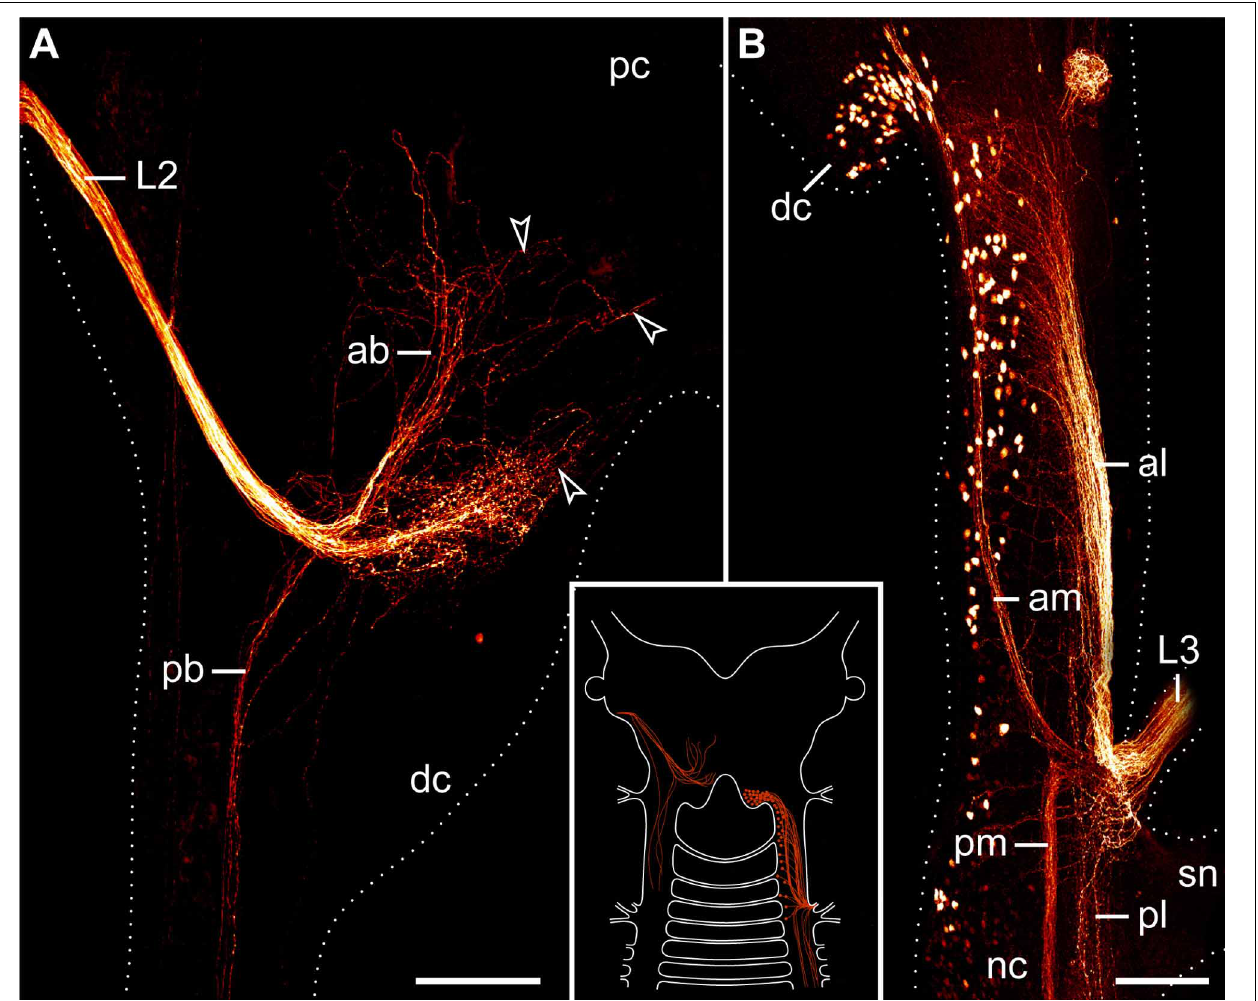
FIGURE 7 | Localization of neuronal somata associated with the second and third lip papillae nerves in Euperipatoides rowelli . Retrograde fills with dextran coupled to a fluorescent marker. Maximum projection confocal micrographs. Anterior is up in all images. Inset illustrates the position of the labeled somata and fibers in the central nervous system. (A) Fill of the second lip papillae nerve (L2). Note the lack of neuronal cell bodies associated with the L2 fibers (arrowheads).